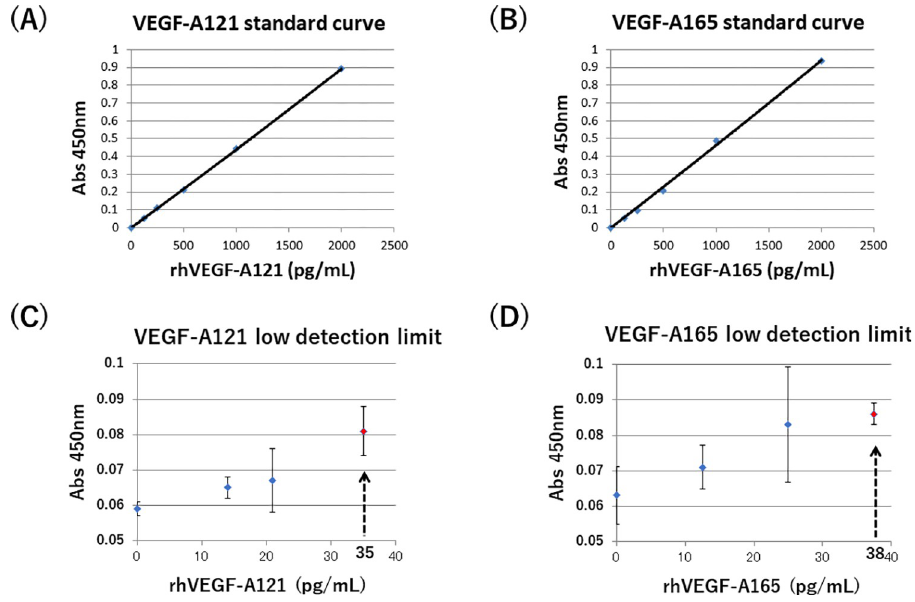
Fig 3. Standard curves for VEGF-A121 ELISA and VEGF-A165 ELISA and low detection limits of each ELISA. (A, B) A standard curve of rhVEGF-A121 by VEGF-A121 ELISA (A) and a standard curve of rhVEGF-A165 by VEGF-A165 ELISA (B) were independently created. (C, D) Different lower detection limits for rhVEGF-A121 and rhVEGF-A165 were determined in each ELISA (n = 5); the ELISA lower detection limits for VEGF-A121 or VEGF-A165 were 35 pg/mL (C) or 38 pg/mL (D), respectively. Abs 450 nm represents absorbance at 450 nm.